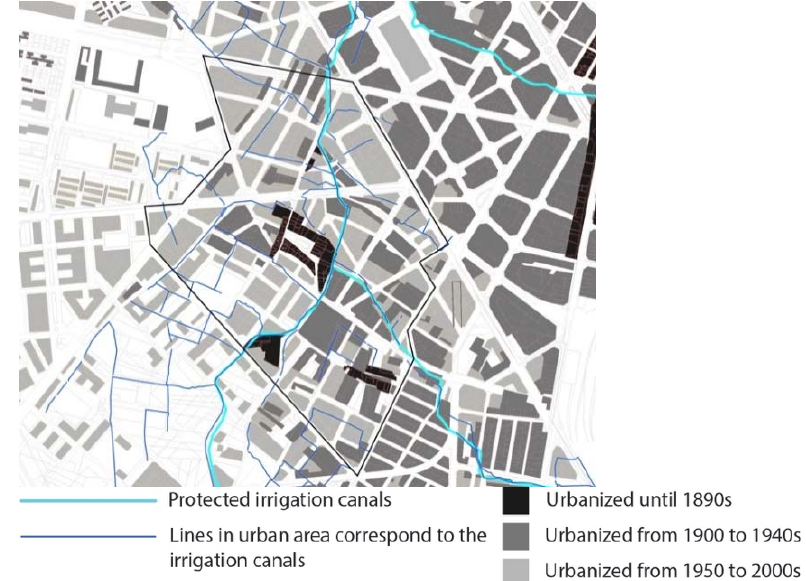
Figure 23. The transition of the irrigation canals in Patraix.